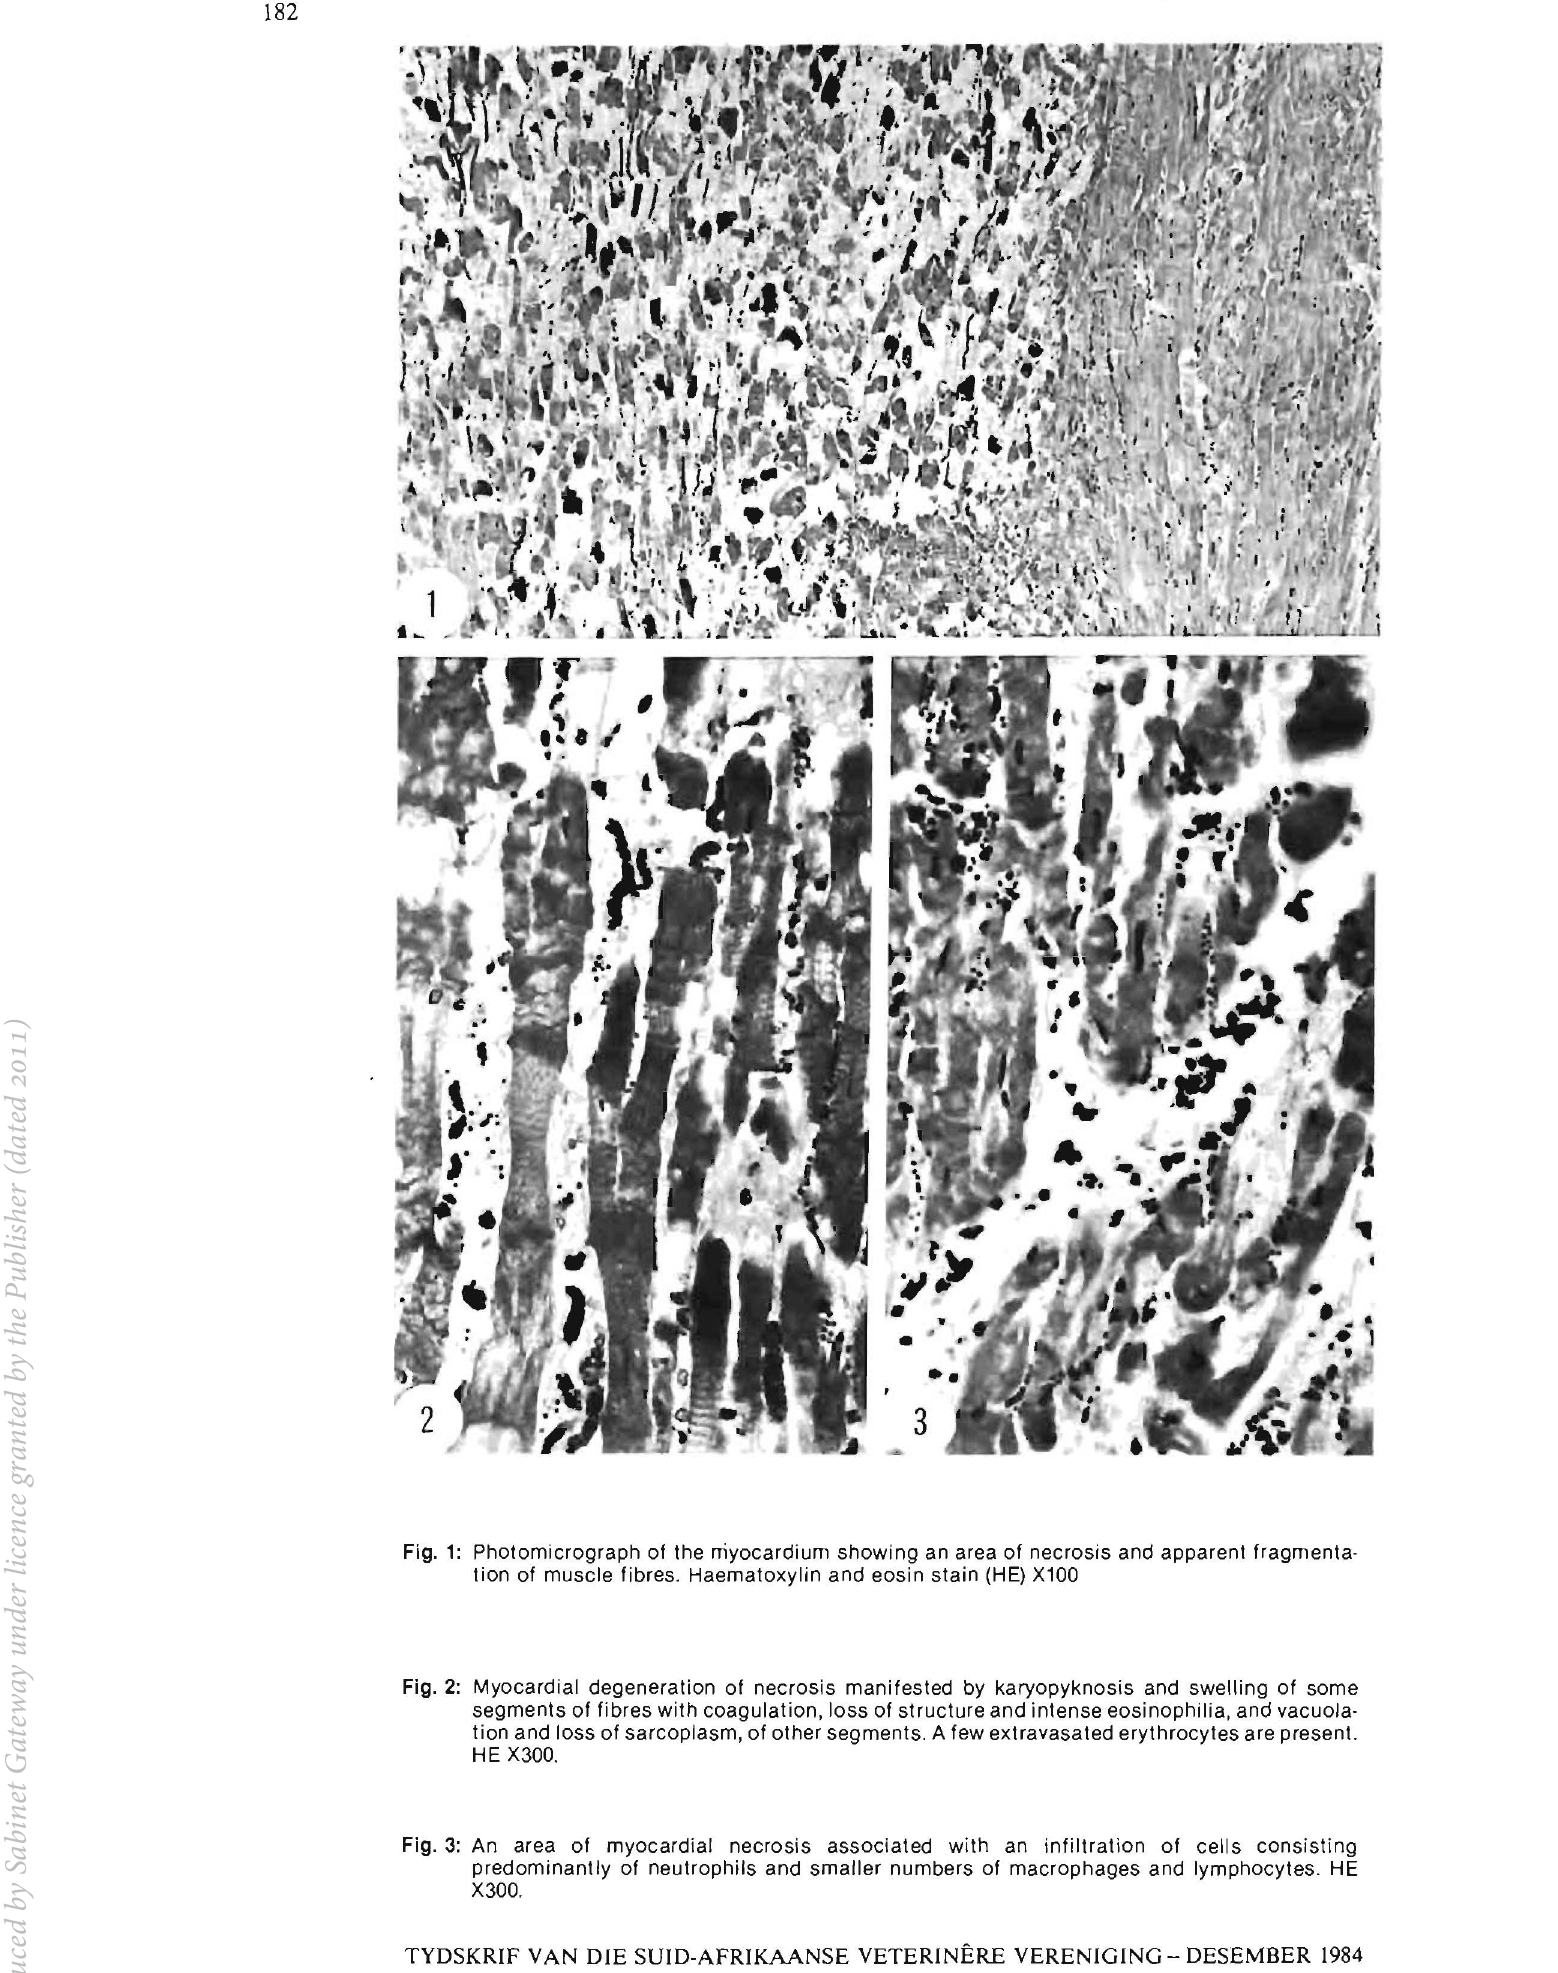
Fig. 3: An area of myocardial necrosis associated with an infiltration of cells consisting predominantly of neutrophils and smaller numbers of macrophages and lymphocytes. HE